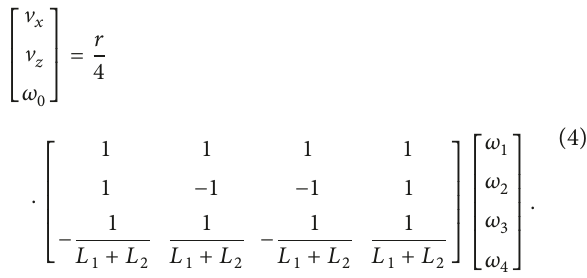
Figure 4: Structural schematic diagram of the